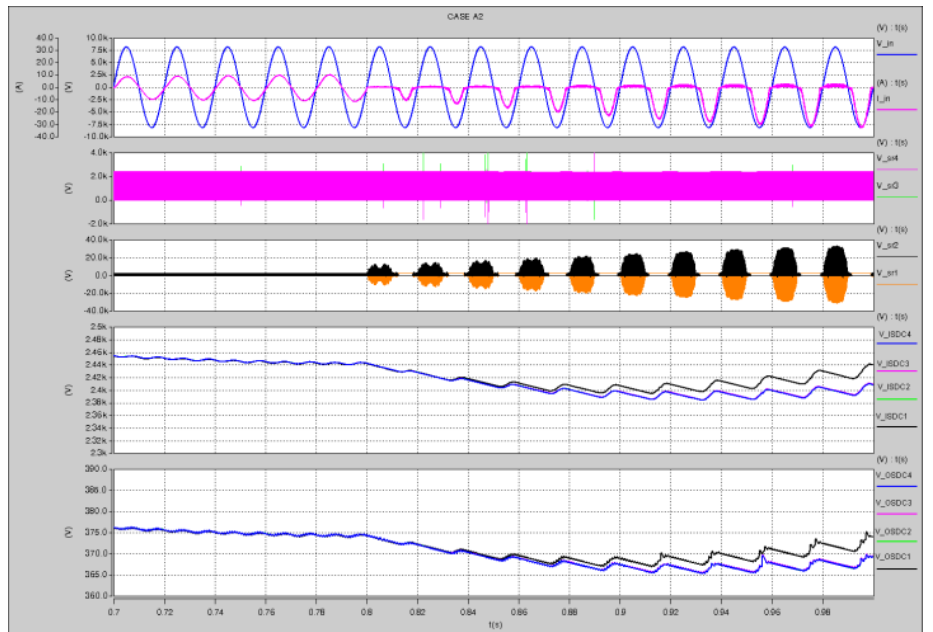
Figure 13. Simulation results of fault